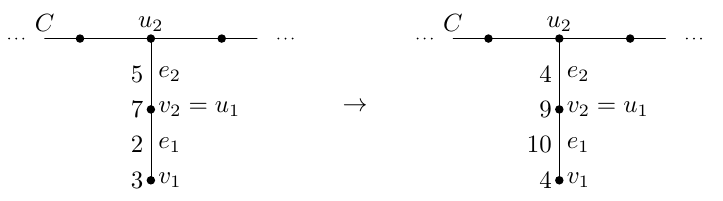
Figure 4: Recoloring of edges e